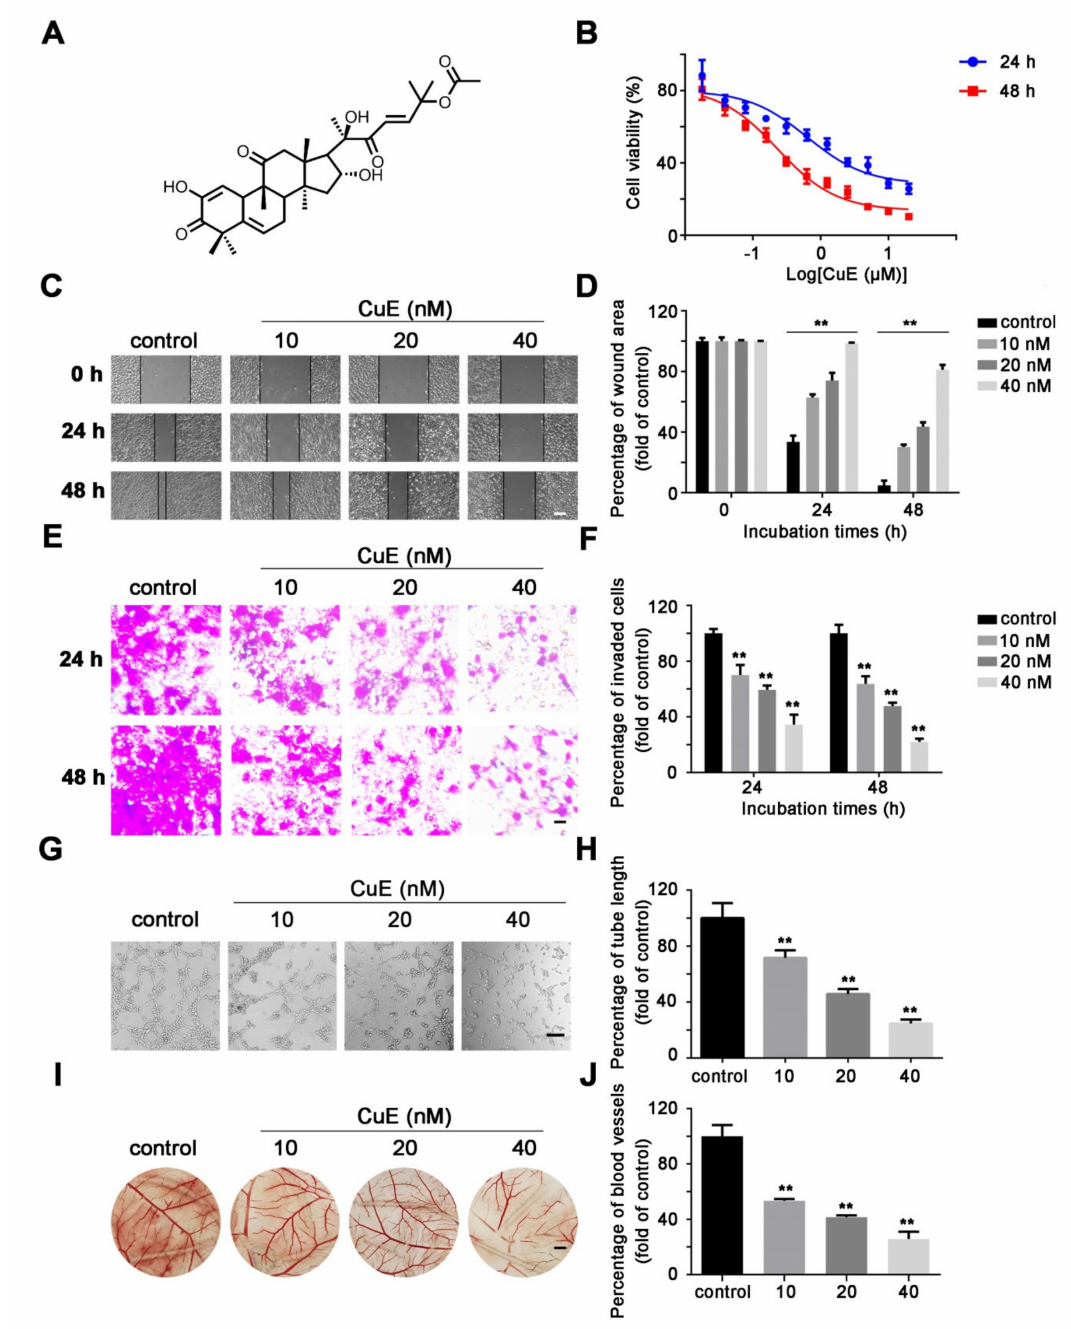
Figure 1. CuE inhibited migration, invasion and angiogenesis. ( A ) Chemical structure of CuE. ( B ) Huh7 cells were treated with various concentrations of CuE for 24 or 48 h and the cell viability was evaluated by MTT assay. ( C ) Wound healing assay. HuH7 cells were treated with CuE (0, 10, 20, and 40 nM) for 24 h and 48 h, and the migration of Huh7 cells was quantified by measuring wound areas (bar = 200 µ m). ( D ) Relative migration was calculated by comparing the cells migrated to the wounded area after CuE treatment, with those of control cells. Data are mean ± SD of three independent experiments (n = 3). **: p < 0.01, compared with the control group. ( E ) The cell invasion was determined by transwell invasion assay. After incubation at 37 ◦ C for 24 and 48 h, the migrated cells were fixed and stained with crystal violet solution (bar = 400 µ m). ( F ) Relative migration was calculated by comparing the cells migrated through the chamber membrane after CuE treatment, with those of control cells. Data are mean ± SD of three independent experiments (n = 3). **: p < 0.01, compared with the control